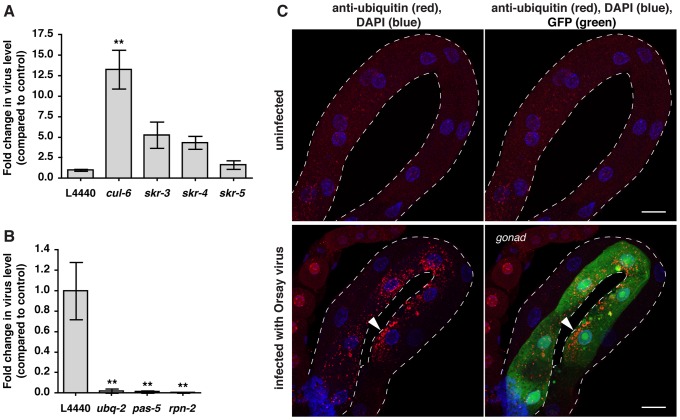
Ubiquitin-mediated host response and defense against Orsay viral infection in C. elegans.A) Viral pathogen load in nematodes treated with RNAi against the SCF ligase components skr-3, skr-4, skr-5, and cul-6 compared to vector control RNAi (L4440), as assessed by qRT-PCR for viral transcript. Mean +/− SEM of three independent experiments shown. B) Viral pathogen load in nematodes treated with RNAi against ubq-2, pas-5 and rpn-2 analyzed as above. Mean +/− SEM of three independent experiments shown. C) Intestines of F26F2.1p::gfp transgenic animals were stained with the FK2 antibody against conjugated ubiquitin (red), and DAPI for DNA (blue). Intestines outlined with white dotted line. Animals infected with virus have increased ubiquitin clustering in some intestinal cells compared to uninfected animals (arrowhead), and also express the GFP reporter. Scale bar  = 20 µm. ** p<0.01.